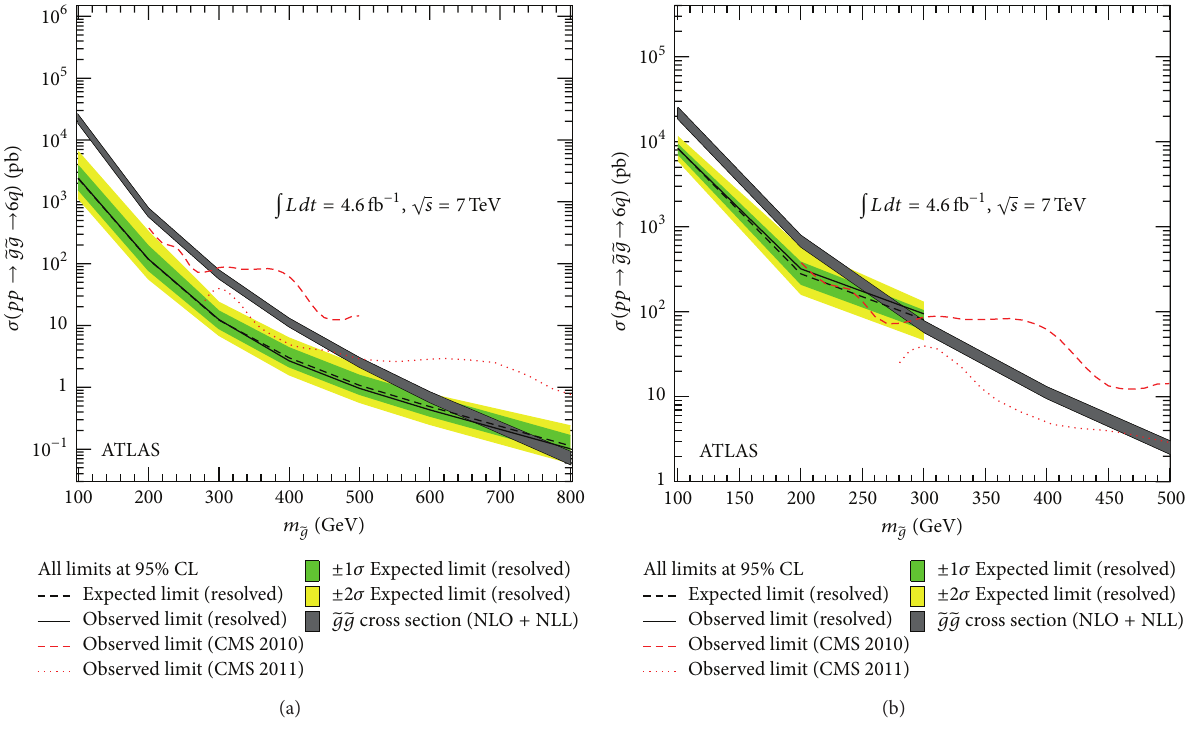
Figure 9: Exclusion of a search in multijet final state (a) and a boosted resonance search with fat jets (b) on the same 7 TeV data set of ATLAS [15]. Color codes as in Figure